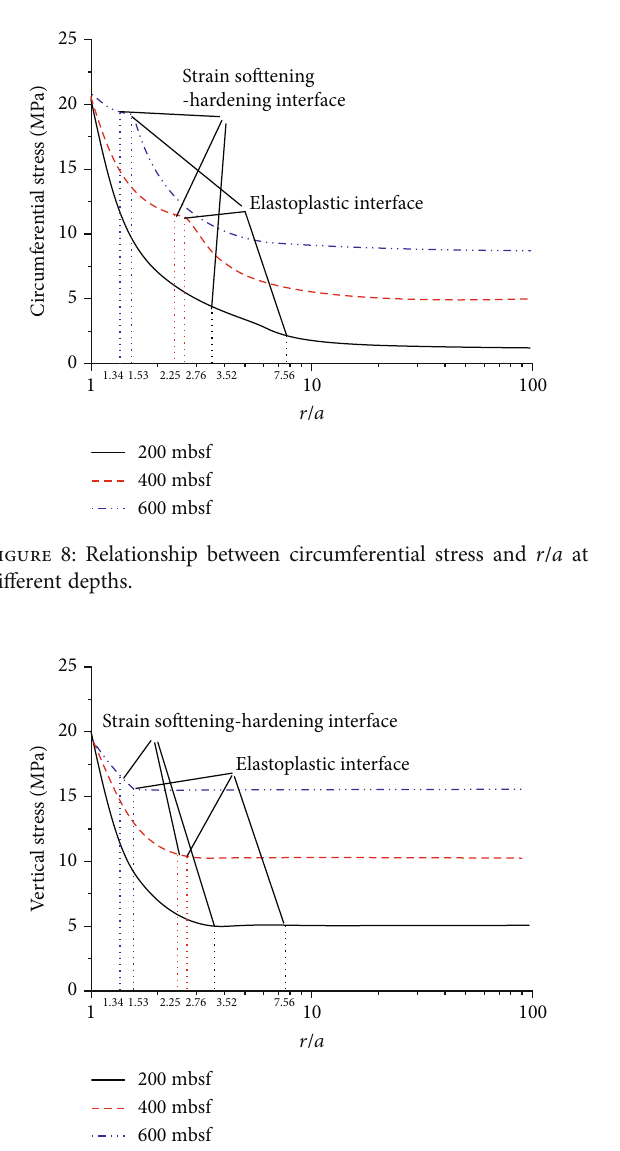
Figure 9: Relationship between vertical stress and r / a at di ff erent depths.